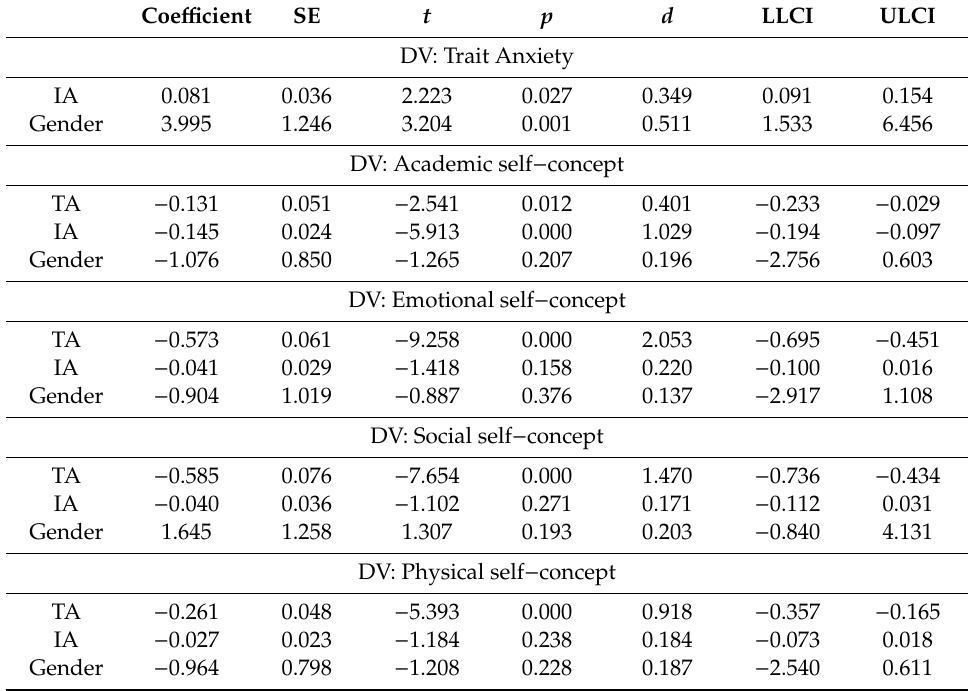
Table 2. Results of the mediational analysis for the inattention